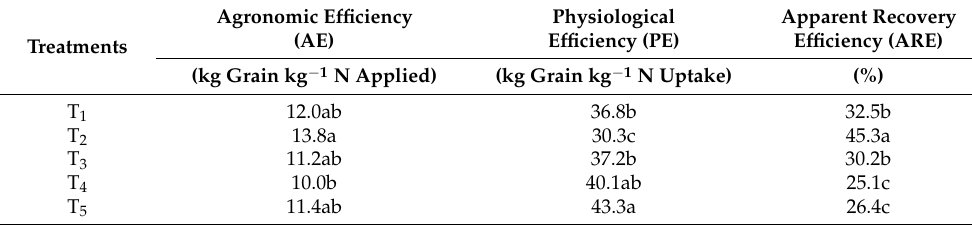
Per column, same letter(s) indicate statistically similar, and dissimilar letter(s) indicate significant differ- ence at 0.05 level of probability: T 0 , control; T 1 , mineral fertilizers only (STB); T 2 , vermicompost (10 t ha − 1